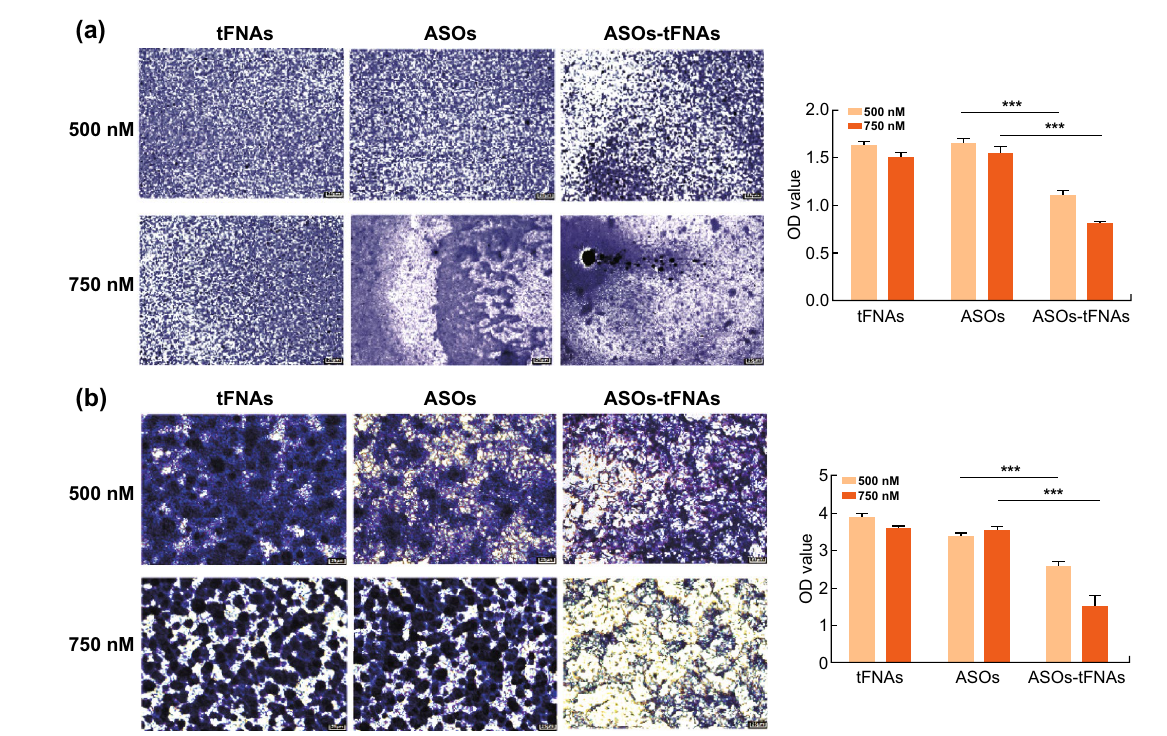
Fig. 3 ASOs-tFNAs inhibit biofilm formation. a Crystal violet staining of S. mutans cells treated with different concentrations of tFNAs, ASOs, and ASOs-tFNAs for 24 h and semiquantitative analysis of biofilm formation, b crystal violet staining of S. mutans cells treated with different concentrations of tFNAs, ASOs, and ASOs-tFNAs for 48 h and semiquantitative analysis of biofilm formation. Data represent the mean ± SD ( n = 3), *** P < 0.001. (Color figure